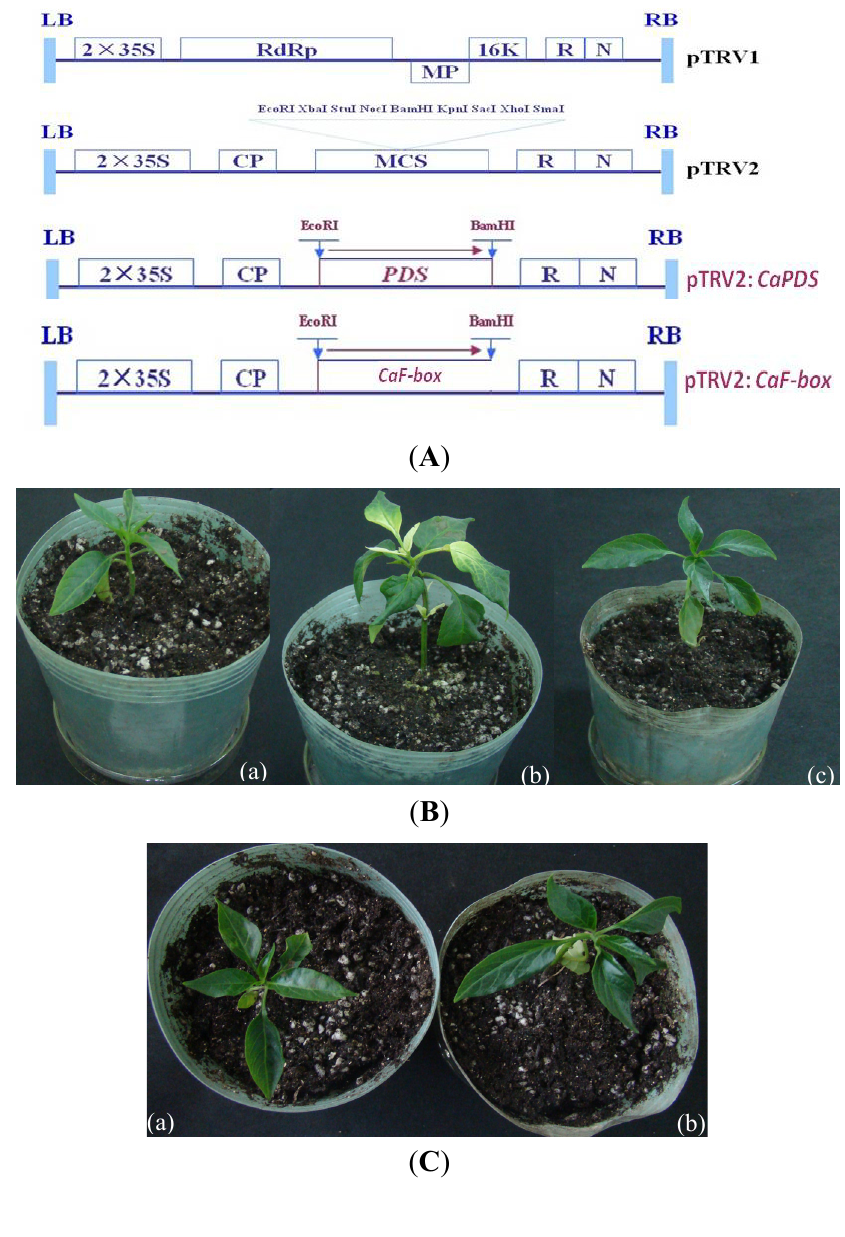
Figure 5. VIGS of CaF-box gene in the pepper plant. ( A ) Schematic representation of the tobacco rattle virus (TRV), pTRV2: CaPDS and pTRV2: CaF-box constructs; ( B ) Phenotypes of gene silencing pepper plants. ( a ) Control plant (pTRV2-00); ( b ) CaPDS -silenced plant (pTRV2: CaPDS ); ( c ) CaF-box- silenced plant (pTRV2: CaF-box ); ( C ) Phenotypes of the control plant and gene silenced plant after 24 h 6 °C treatment. ( a ) Control plant (pTRV2-00); ( b ) CaF-box- silenced plant (pTRV2: CaF-box ); ( D ) Real-time RT-PCR analysis of relative CaF-box expression levels in gene-silenced (pTRV: CaF-box ) and control (pTRV:00) plants 45 days after inoculation; ( E ) Effects of low temperature stress on EC1/EC2; and ( F ) TBARS in CaF-box- silenced pepper seedlings. Asterisks indicate significant differences compared to empty vector control leaves based on the least significant difference (LSD) test ( p < 0.05). Different letters indicate significant differences ( p <